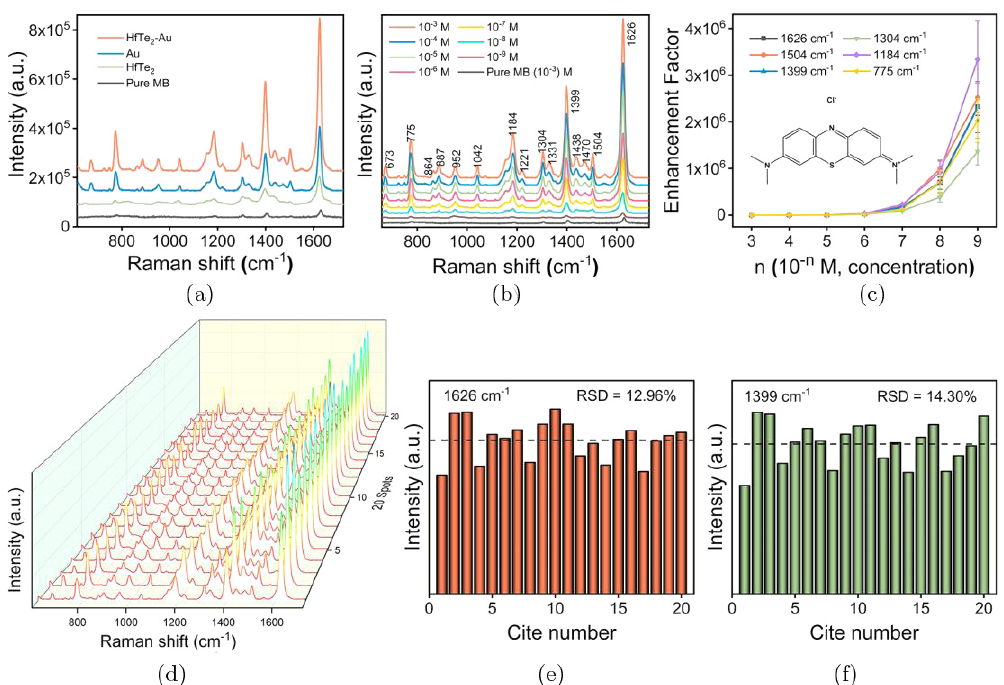
Fig. 4. (a) Raman spectra of MB deposited on HfTe 2 -Au nanocomposites, Au NPs, HfTe 2 nanosheets and SiO 2 wafer, respectively. (b) SERS spectra of di®erent concentrations of MB molecules on HfTe 2 -Au substrate. (c) The EF values of six typical Raman peaks of MB (on HfTe 2 -Au substrate) at di®erent concentration levels. (d) SERS spectra of MB on HfTe 2 -Au substrate collected from random twenty positions. (e, f) The intensity distribution of SERS peak at 1626 and 1399 cm (cid:4) 1 in the above 20 spectra.